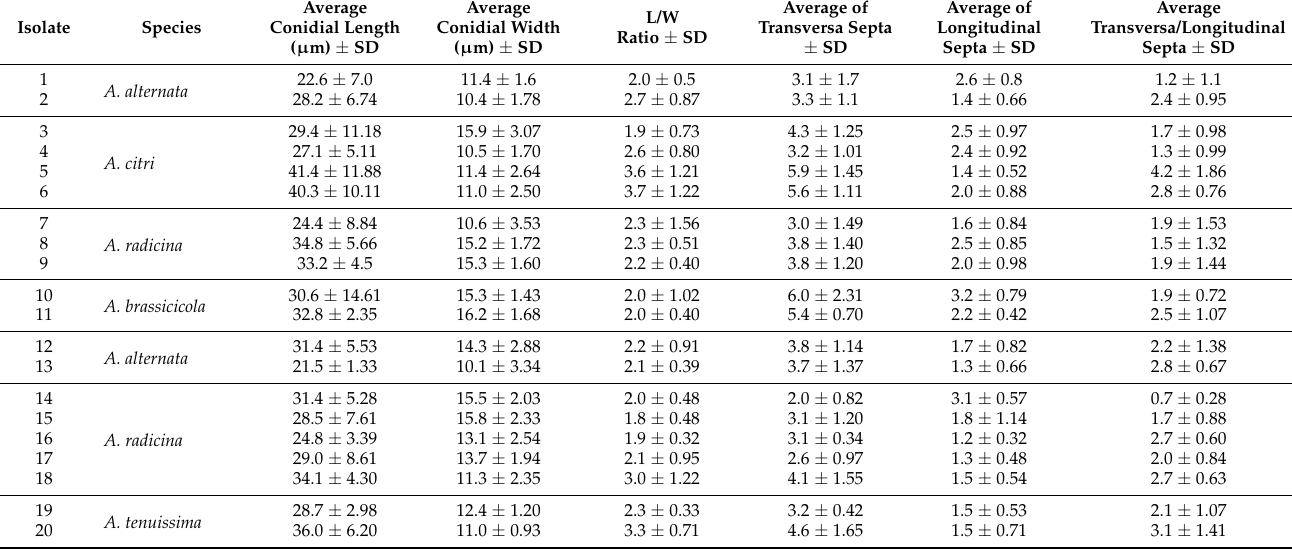
Measurement of different morphological structures of Alternaria species (averages of 10 conidia for each